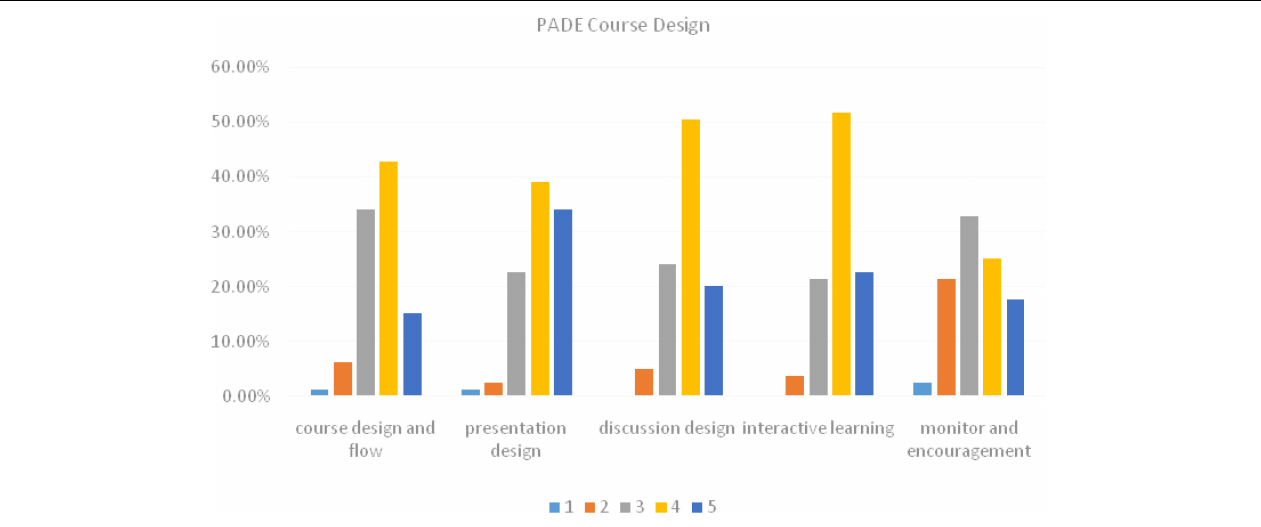
FIGURE 2 | Percentage of the PADE course design: 1 – strongly disagree; 2 – disagree; 3 – neutral; 4 – agree; 5 – strongly agree.